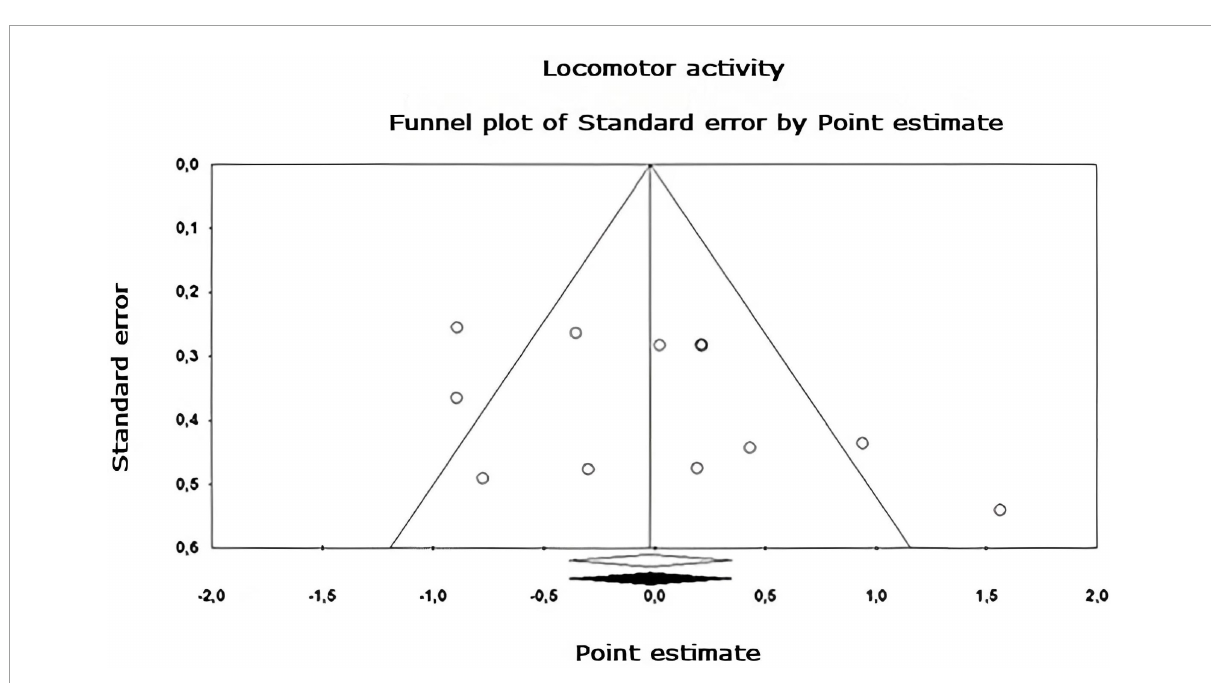
FIGURE7 Funnel plot of publication bias for the locomotor activity sub-metaanalysis, created using the Trim and Fill method (Duval and Tweedie, 2000). It shows an estimate of the effect sizes of all UAs. Data obtained from the experiments are shown in white. No data points were imputed.